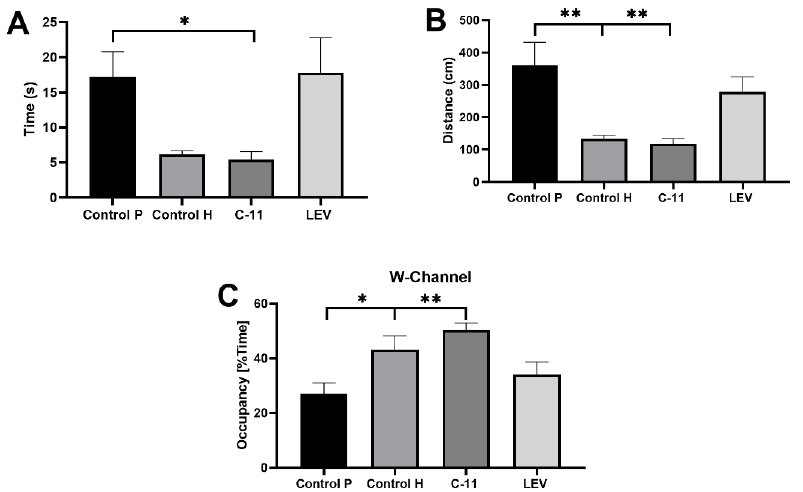
Figure 3. Evaluation of the long-term C11 and LEV administration on the escape latency ( A ), cumulative distance ( B ), and the mean percent of time spent in the W-Channel ( C ) in mice after PILO-induced SE in the Morris Water Maze test. Four groups were tested as follows: control PILO group, control healthy group, C11 (20 mg/kg), and LEV (10 mg/kg). The results were analyzed using one-way analysis of variance (ANOVA), followed by Dunnett’s test for multiple comparisons. Each bar represents the mean for eight mice; error bars are S.E.M. * p < 0.05 and ** p < 0.01; n = 8).